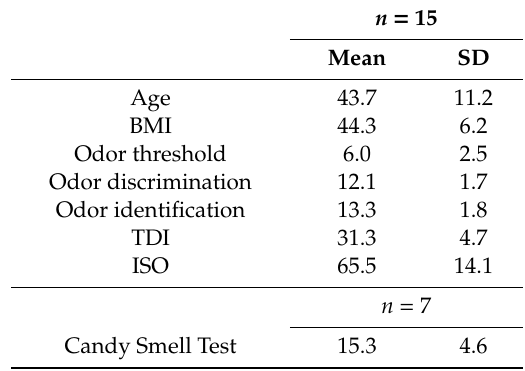
Table 3. Subject characteristics and obtained scores at enrollment of the prospective pilot